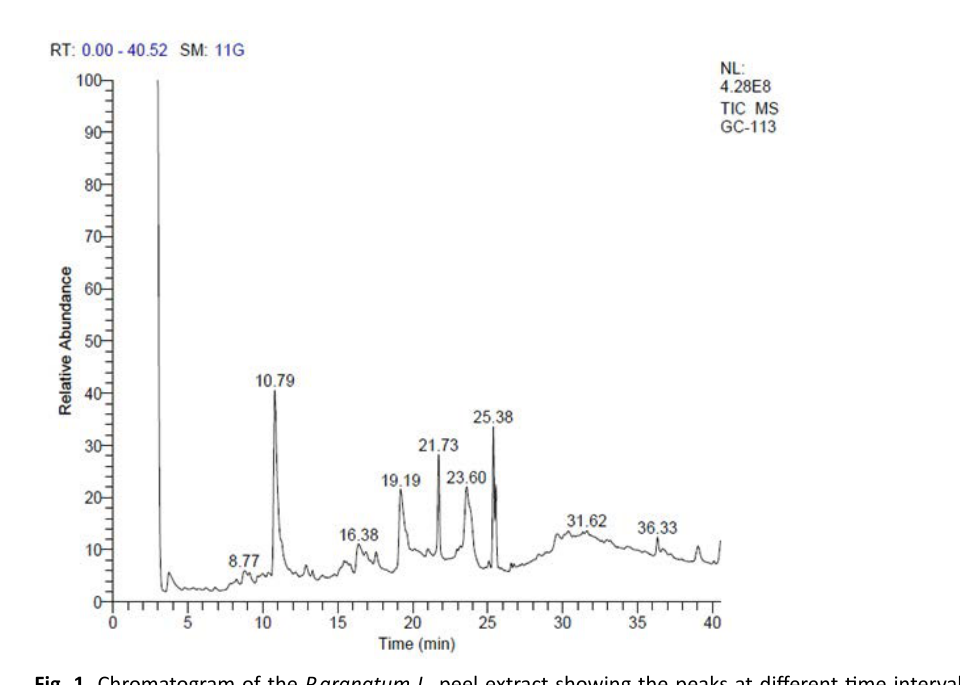
Fig. 1. Chromatogram of the P.granatum L. peel extract showing the peaks at different time intervals and with relative